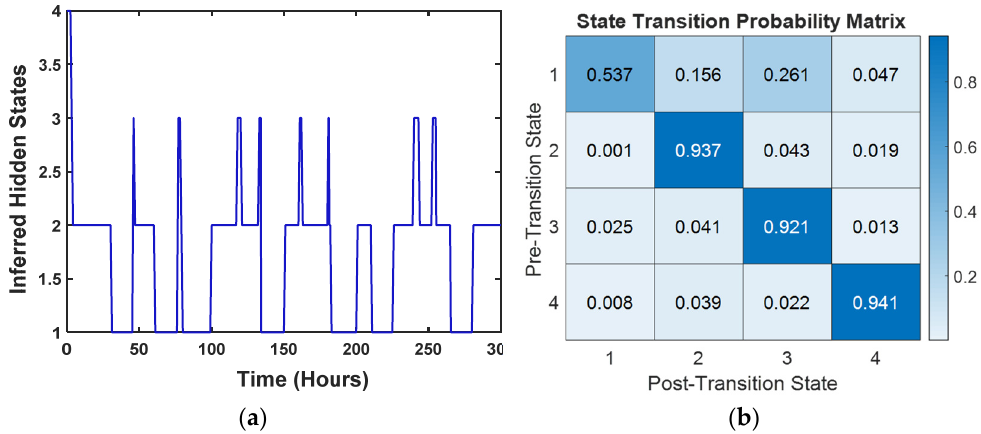
Figure 7. ( a ) Inferred hidden states for lubricating oil degradation with irregular oil replenishments and oil changes; ( b ) state transition probability matrix for estimated state space.